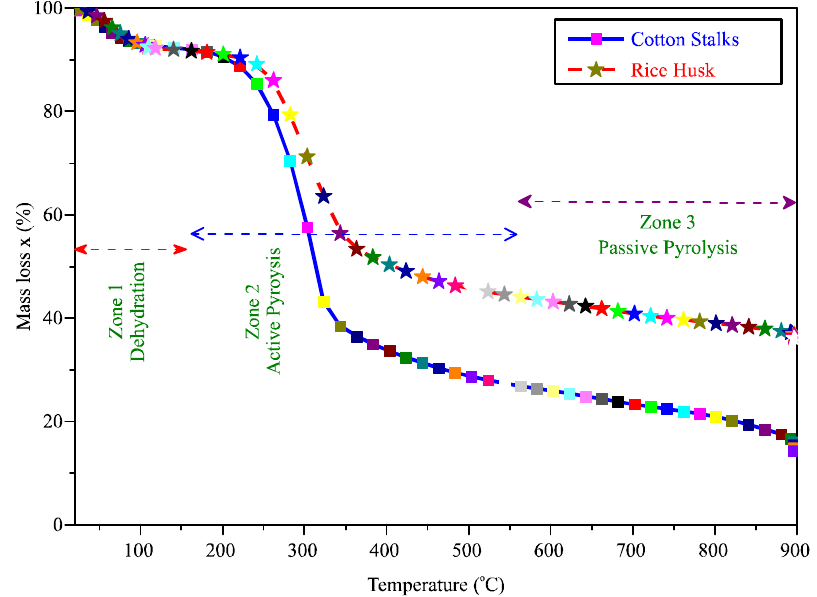
FIG. 2. TGA CURVES OF COTTON STALKS AND RICE HUSK SAMPLES UNDER NITROGEN ENVIRONMENT